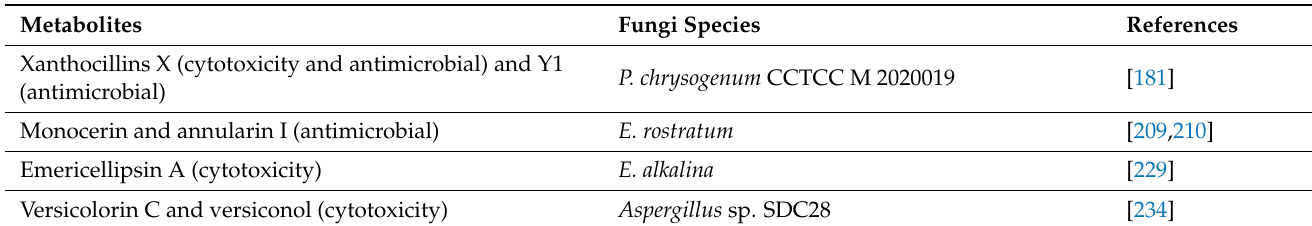
Table 3. Examples of cytotoxic and antimicrobial secondary metabolites produced by extremophilic fungi